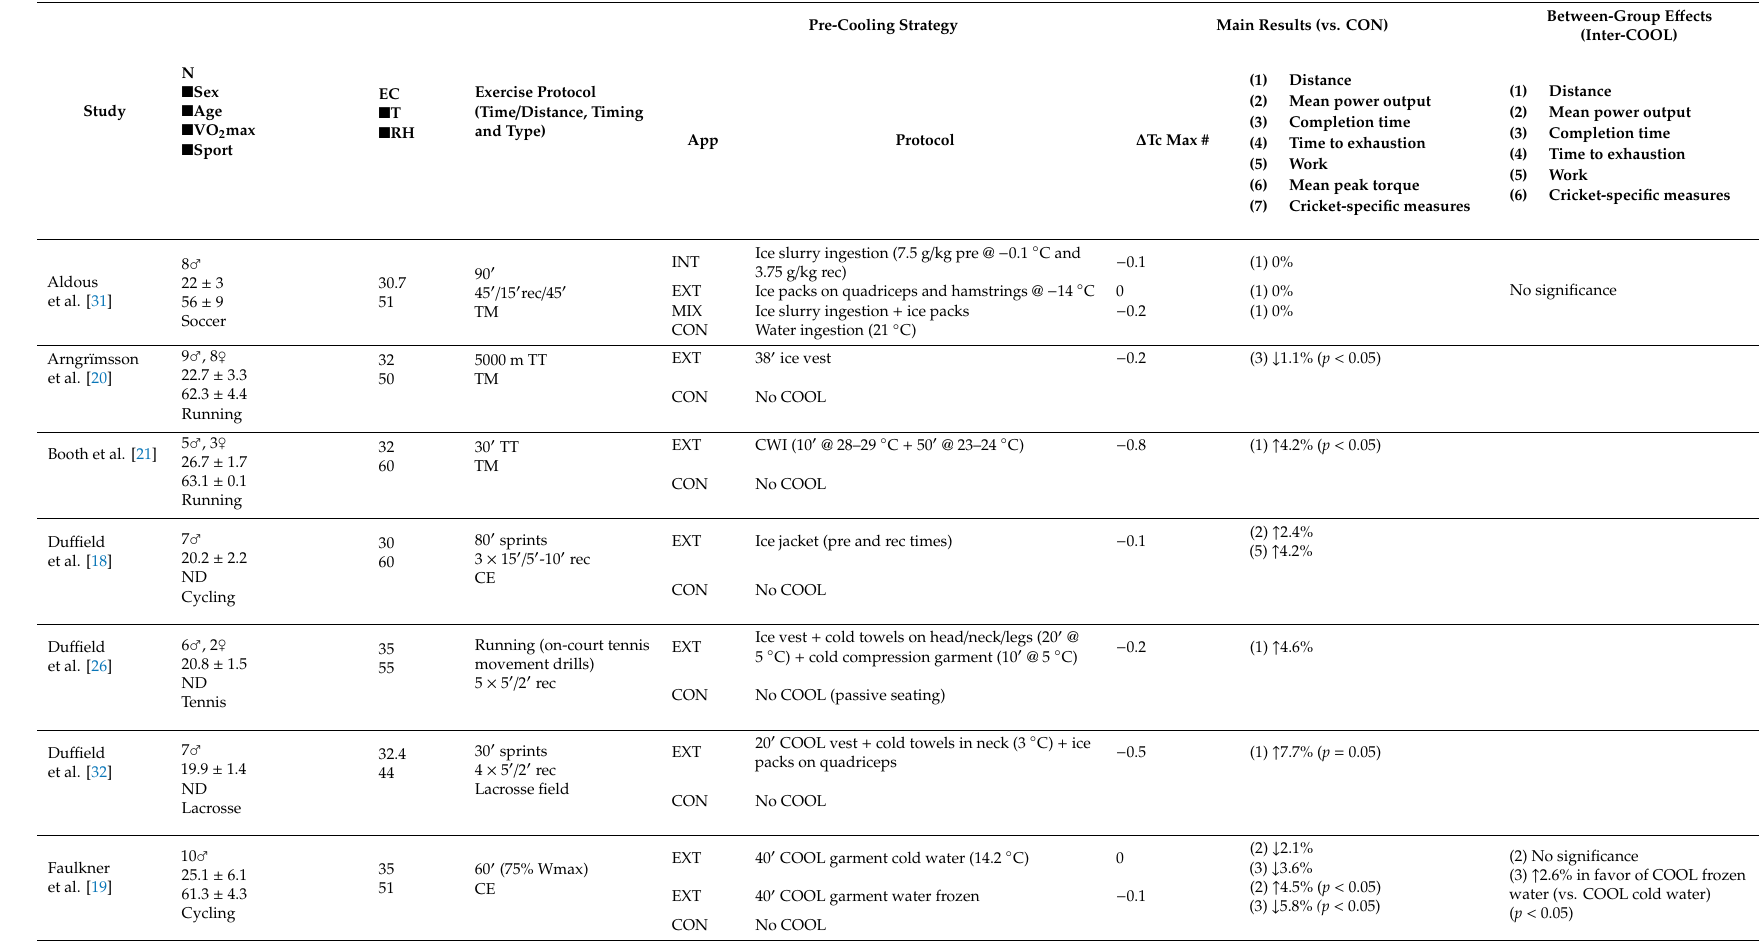
Table 1. Summary of the included